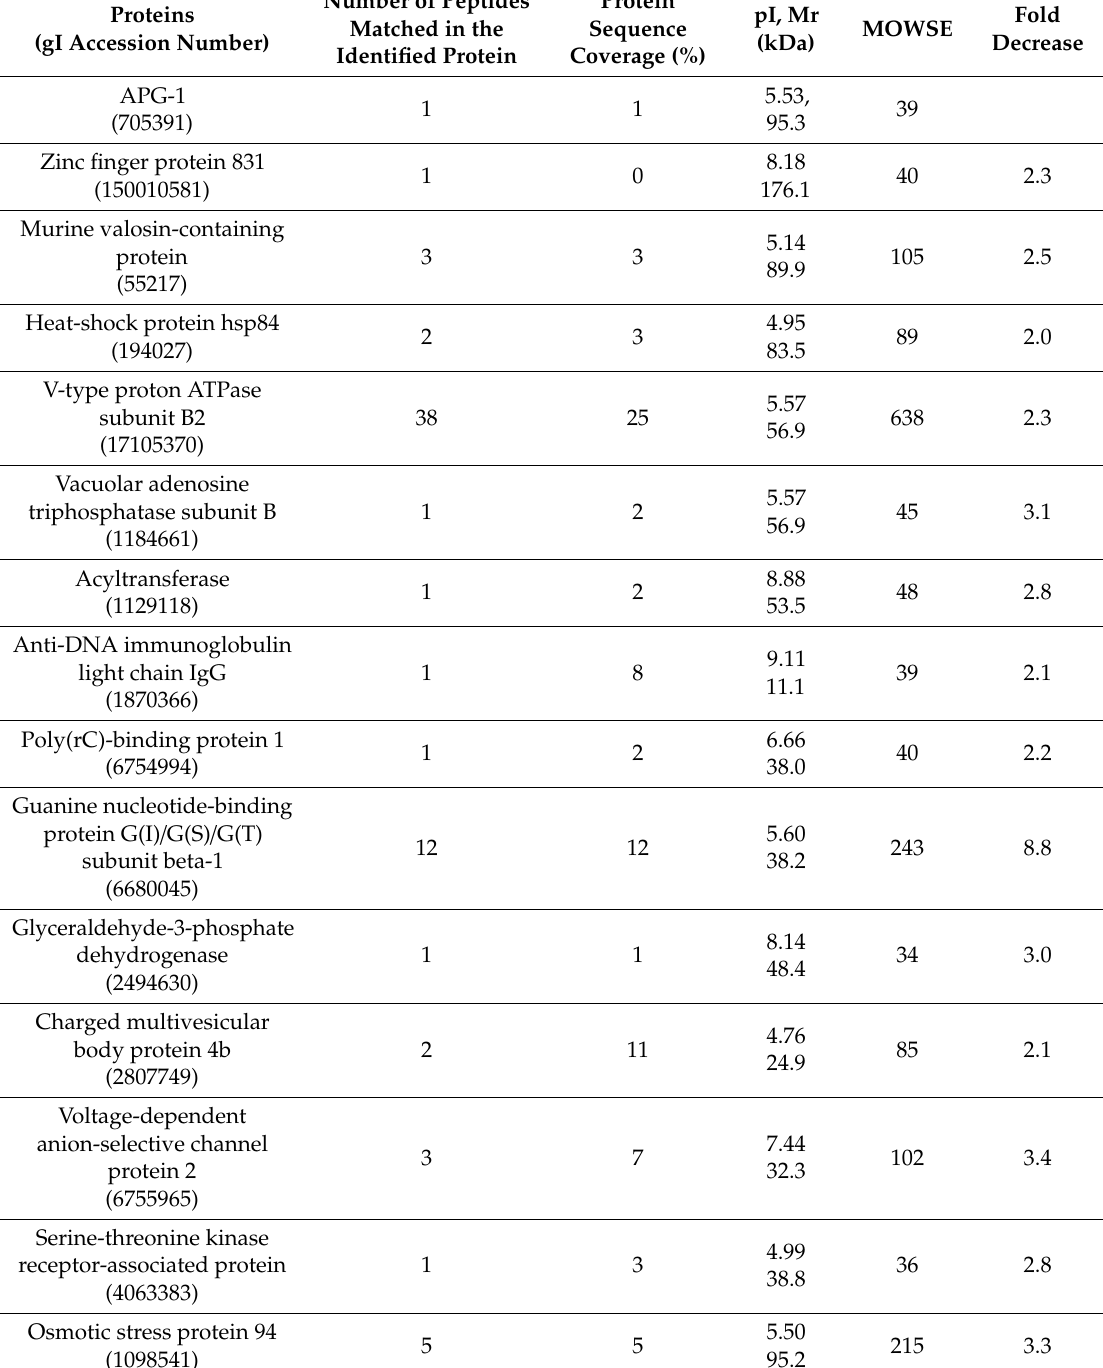
Table1. Identifiedcandidateproteinsinhippocampalhomogenatesdecreasedafterpyridoxine-deficient diet treatment more than two-folds. Note that only V-type proton ATPase subunit B2 (ATP6V1B2) shows more than 20 peptides matched in the identified protein and protein sequence